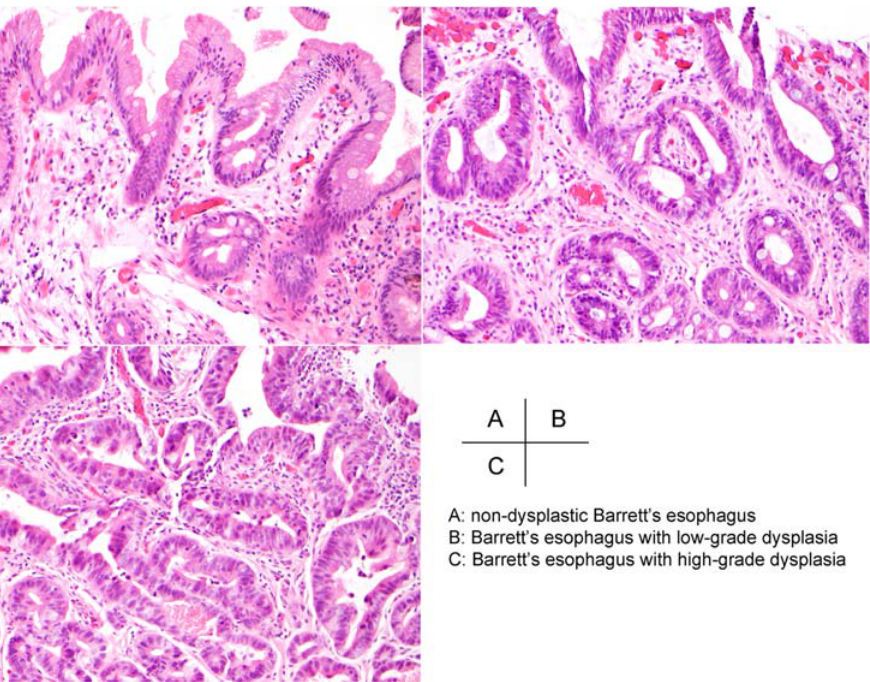
Figure 1. H&E staining of biopsy specimens from patients with Barrett ’ s esophagus. Objective criteria that were used to distinguish LGD and HGD have been published previously [14].